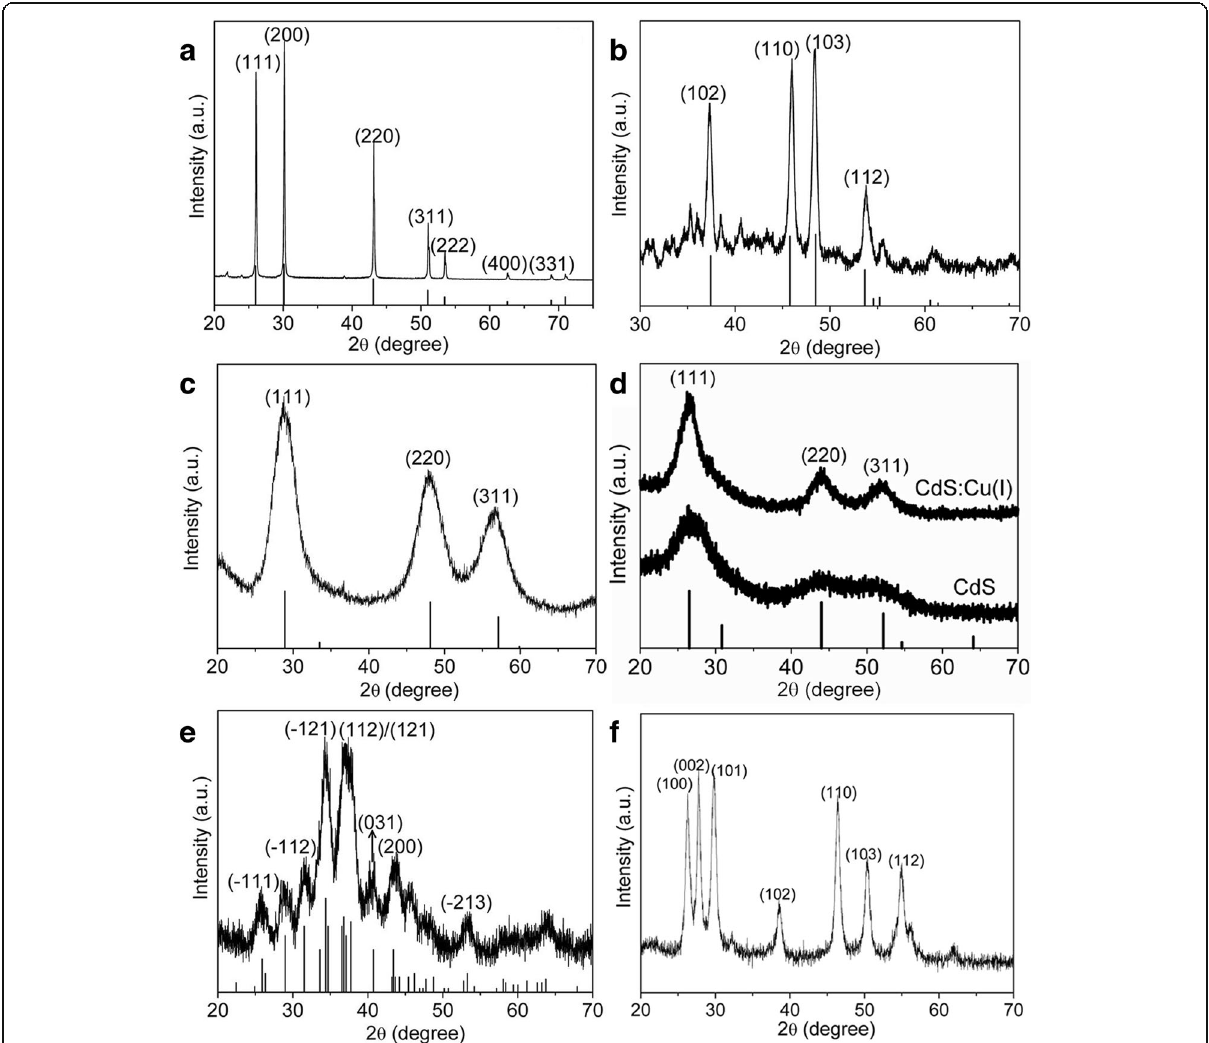
Fig. 4 XRD patterns of the as-obtained different metal sulfide NCs and the corresponding standard diffraction lines are placed at the bottom. a PbS. b